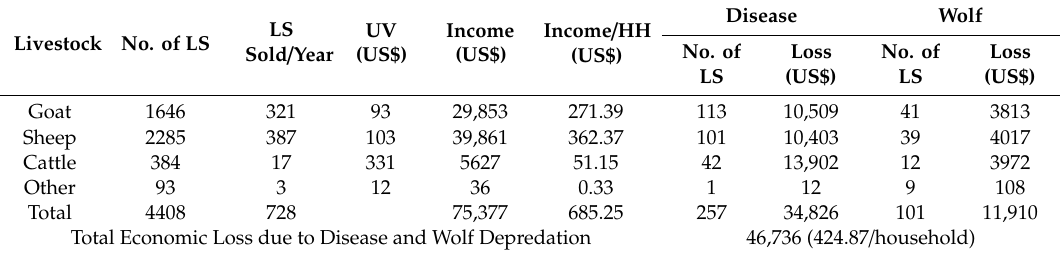
Table 1. Detail of Livestock Holdings, Revenue Generated, and Economic Loss due to Disease and Grey Wolf per